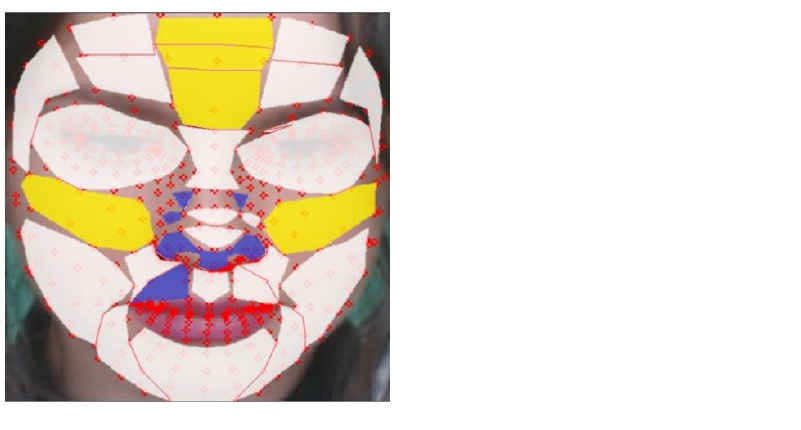
Figure 10. Evaluation of rBS in proposed regions (yellow: TOP-5 regions, blue: BOT-5 regions, white: the other regions).